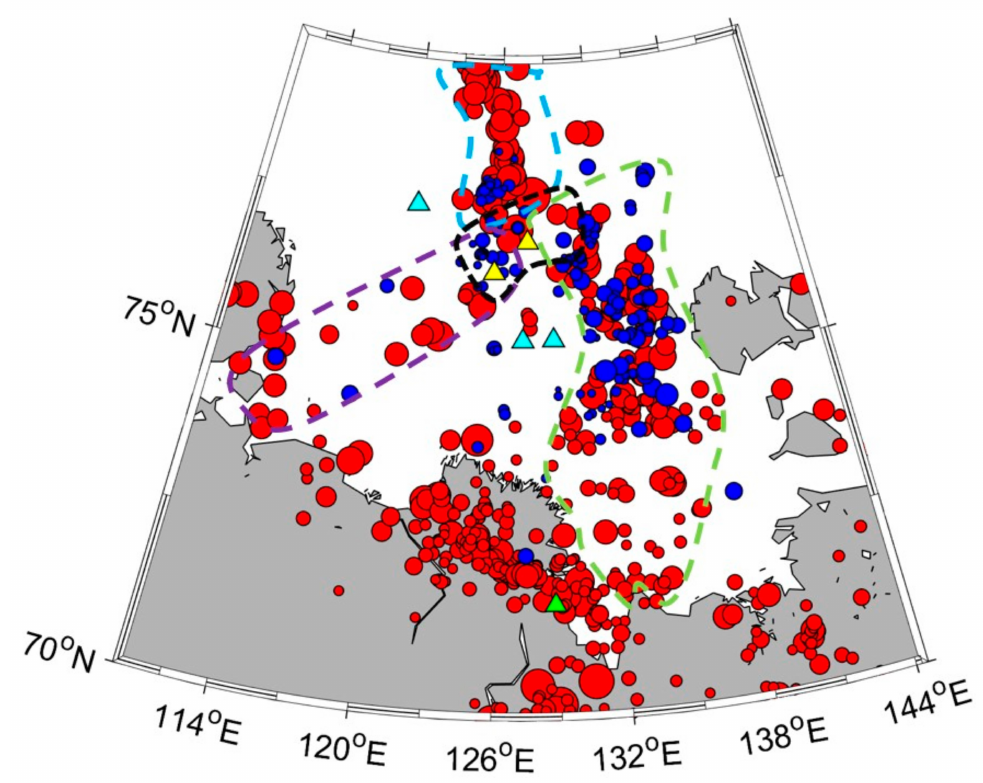
Figure 17. The distribution of the earthquake epicenters in the Laptev Sea region: red circles—the joint regional catalog by ISC [39], USGS [38] and “Earthquakes of Russia” database [40], blue circles—the catalog of the events that were most clearly recorded by the OBSs (several months during 2018– 2020 [20,37]). Location of the OBSs that worked for several months and were successfully dismantled: cyan triangles—in the 2018–2019 season (two MPSSR on the shelf and one GNS-C on the slope); yellow triangles—in the season 2019–2020 (one MPSSR and one Typhoon); green triangle—permanent on-land broadband seismic station of the Geophysical Survey of the Russian Academy of Sciences in the village of Tiksi). The blue dashed line outlines the seismicity belts associated with the Gakkel spreading ridge; the green dashed line—with the East Laptev province of horsts and grabens; the purple dashed line—with the southwestern segment of the Khatango-Lomonosov fault zone; the black dashed line—the area of concentration of gas